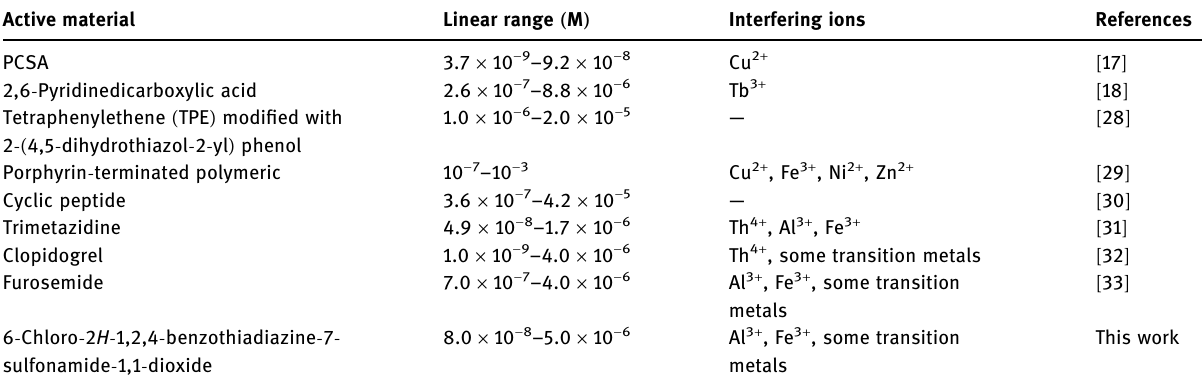
Table 3: Comparison of the analytical parameters of L chemosensor with some of the developed optical sensors Active material Linear range ( M )